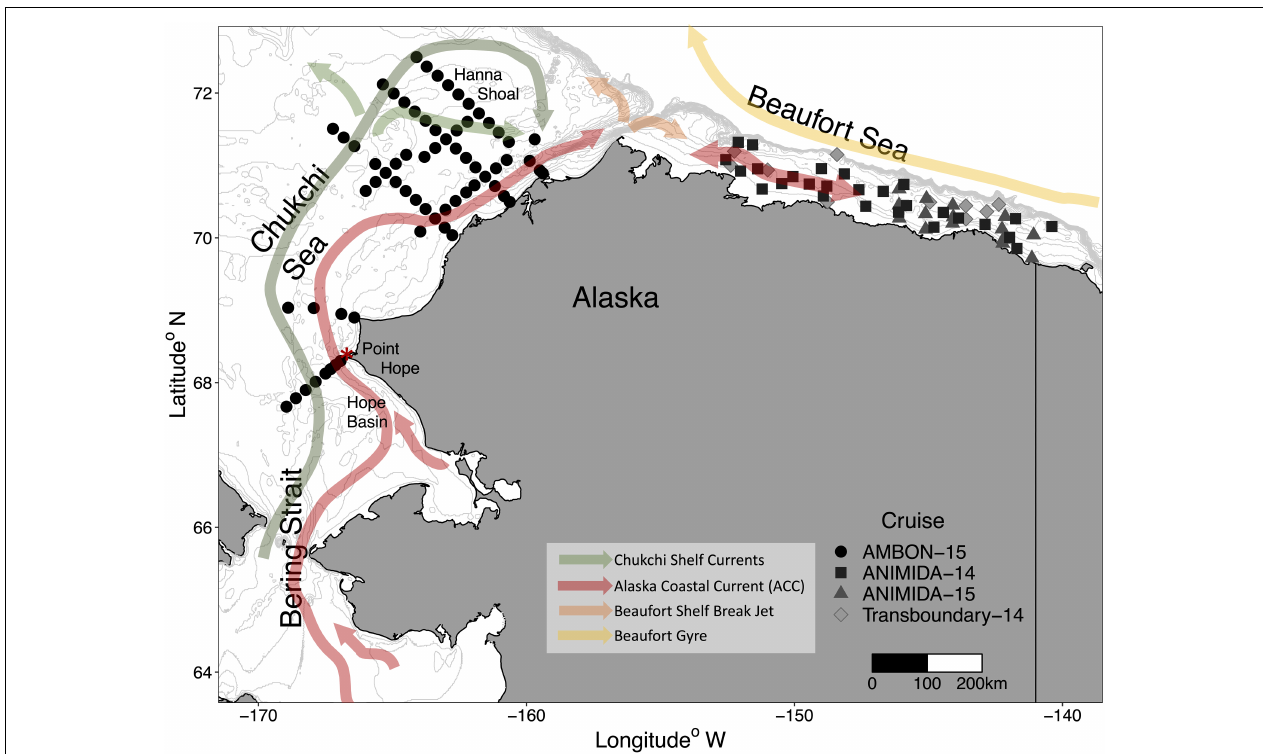
FIGURE 1 | Stations sampled for epibenthic communities during four cruises in the Chukchi and Beaufort seas in 2014 and 2015. Depth contours in the study regions are shown in gray at 10 m intervals. Stations are designated by symbols for different cruises.